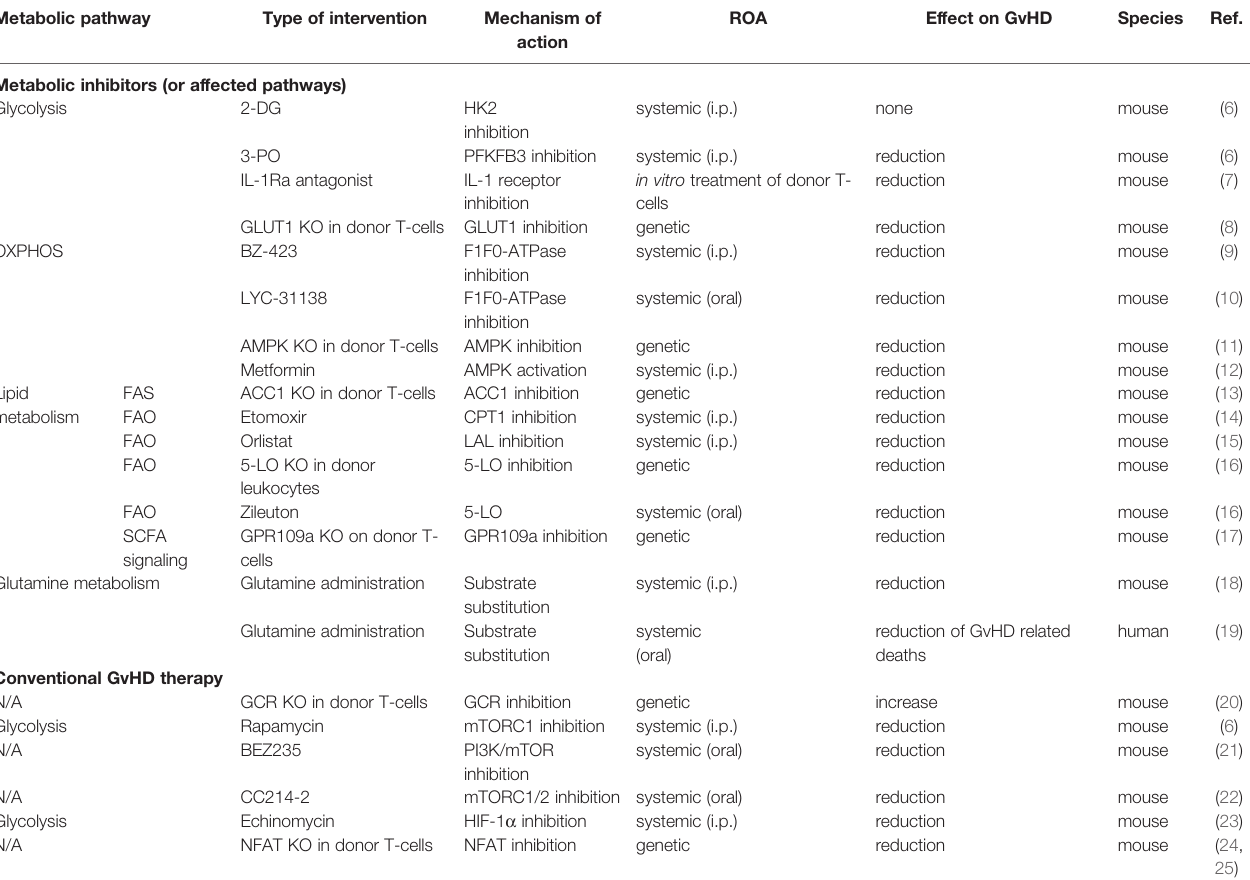
TABLE 1 | Selected in vivo studies investigating the effect of immuno-metabolic interventions and conventional GvHD therapy on T-cell metabolism and on outcome in